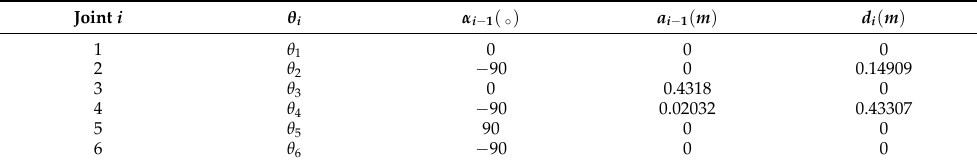
Table 1. Connecting rod parameter of PUMA560